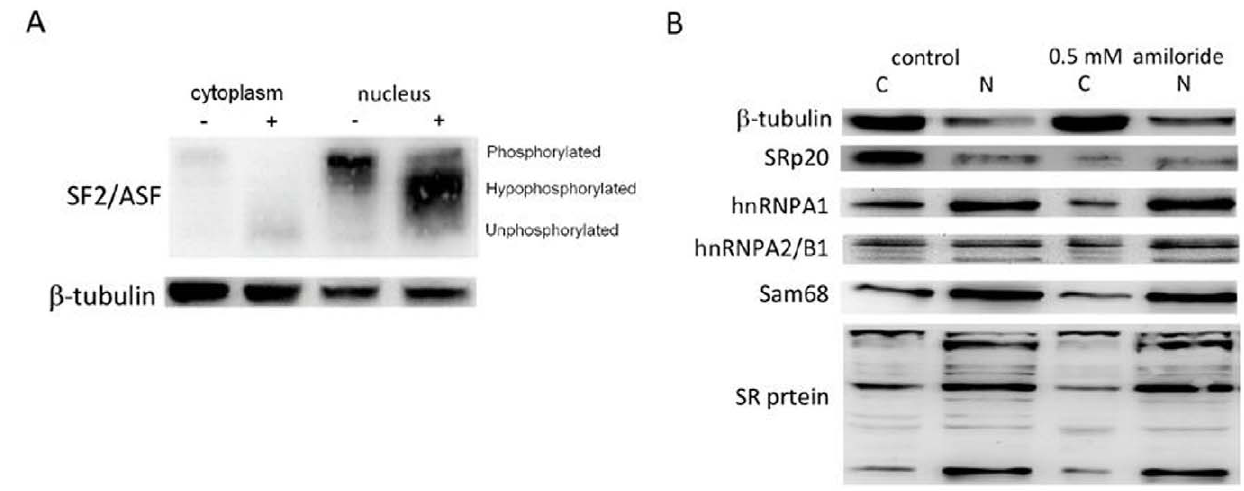
Figure 3. Effects of amiloride treatment on phosphorylation of SR-related proteins. Western blot analysis of subcellular fractions of Huh-7 cells with and without 0.5 mM amiloride 24-hour treatment was performed using specific antibodies against various splicing protein factors and b - tubulin. ( Panel A ) The amiloride treatment increased the dephosphorylated SF2/ASF forms in both cytoplasmic and nuclear fractions. ( Panel B ) The amiloride treatment decreased the expression of SRp20 and two un-identified phosphorylated SR proteins in both C (cytoplasmic) and N (nuclear) cellular fractions. doi:10.1371/journal.pone.0018643.g003 PLoS ONE |